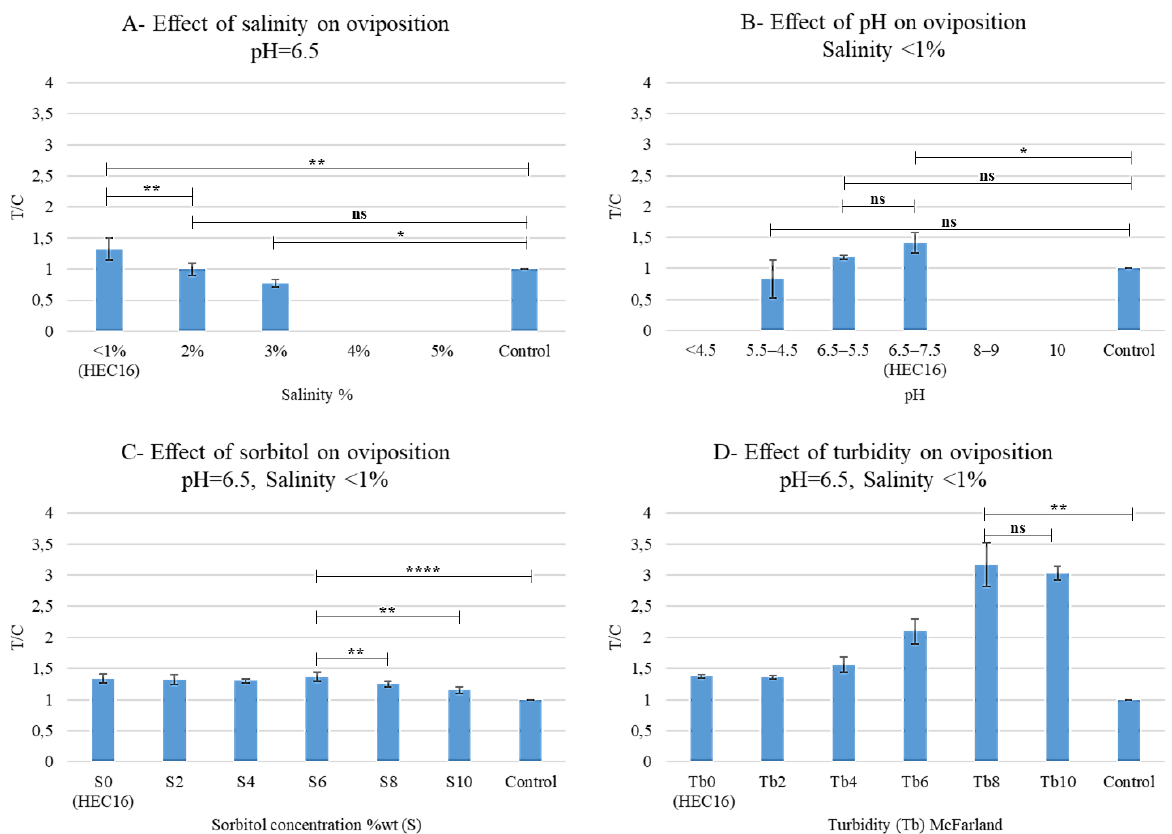
Figure 3. Oviposition assay 2: Effects on oviposition preferences of salinity ( A ), pH ( B ), Sorbitol concentration, S ( C ), and turbidity Tb ( D ). Paper was used as control. T/C is the ratio between eggs laid on sample (T) and control (C). All the tests were carried at 25 °C and 80% of relative humidity (RH). Statistical analysis legend: p > 0.0123 = not significant (ns); p < 0.033 = *; p < 0.0021 = **; p < 0.0001 = ****.